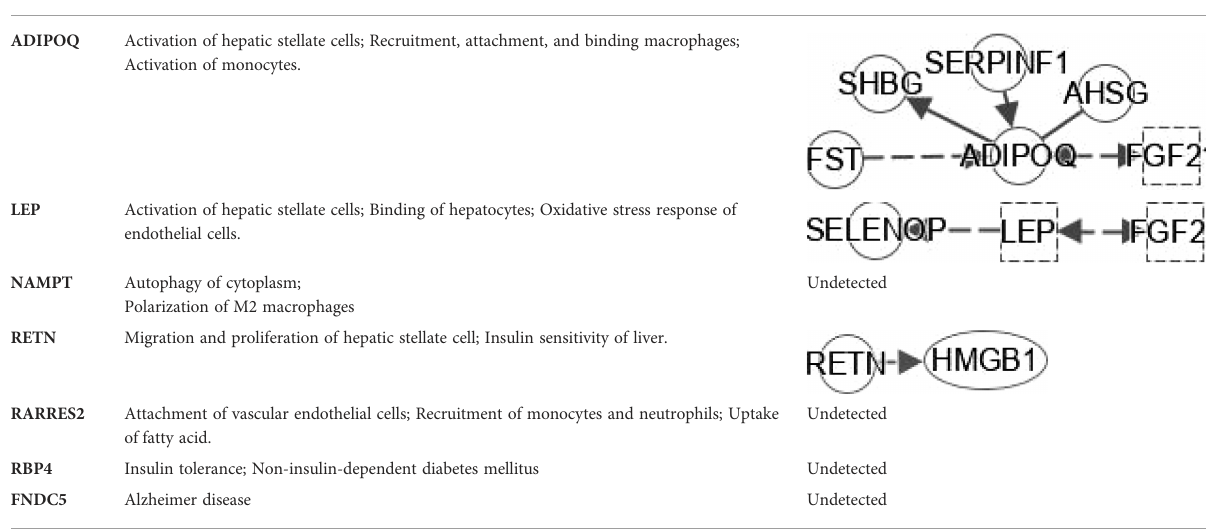
TABLE 2 IPA analysis of Cell-cell signaling/interaction of adipokine and interplay with hepatokines.